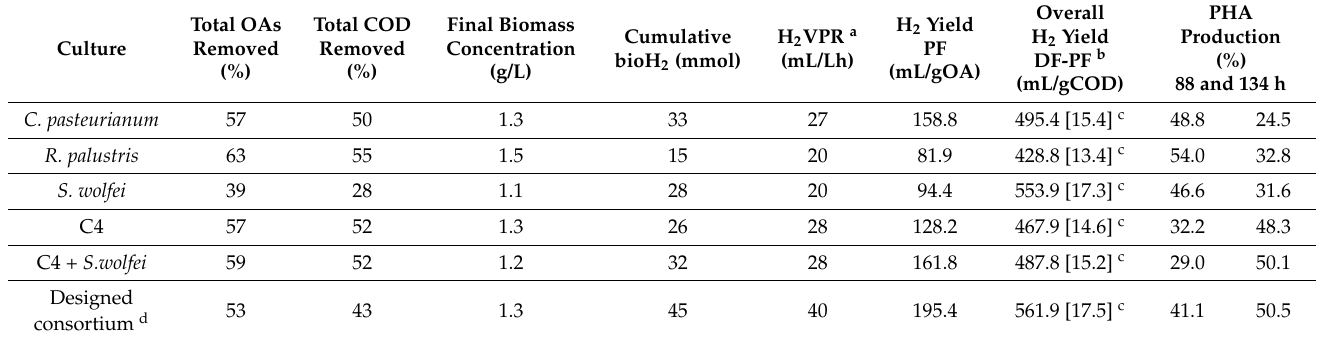
Table 1. Summary and comparison of OA consumption, biomass production, and bioH 2 and PHA